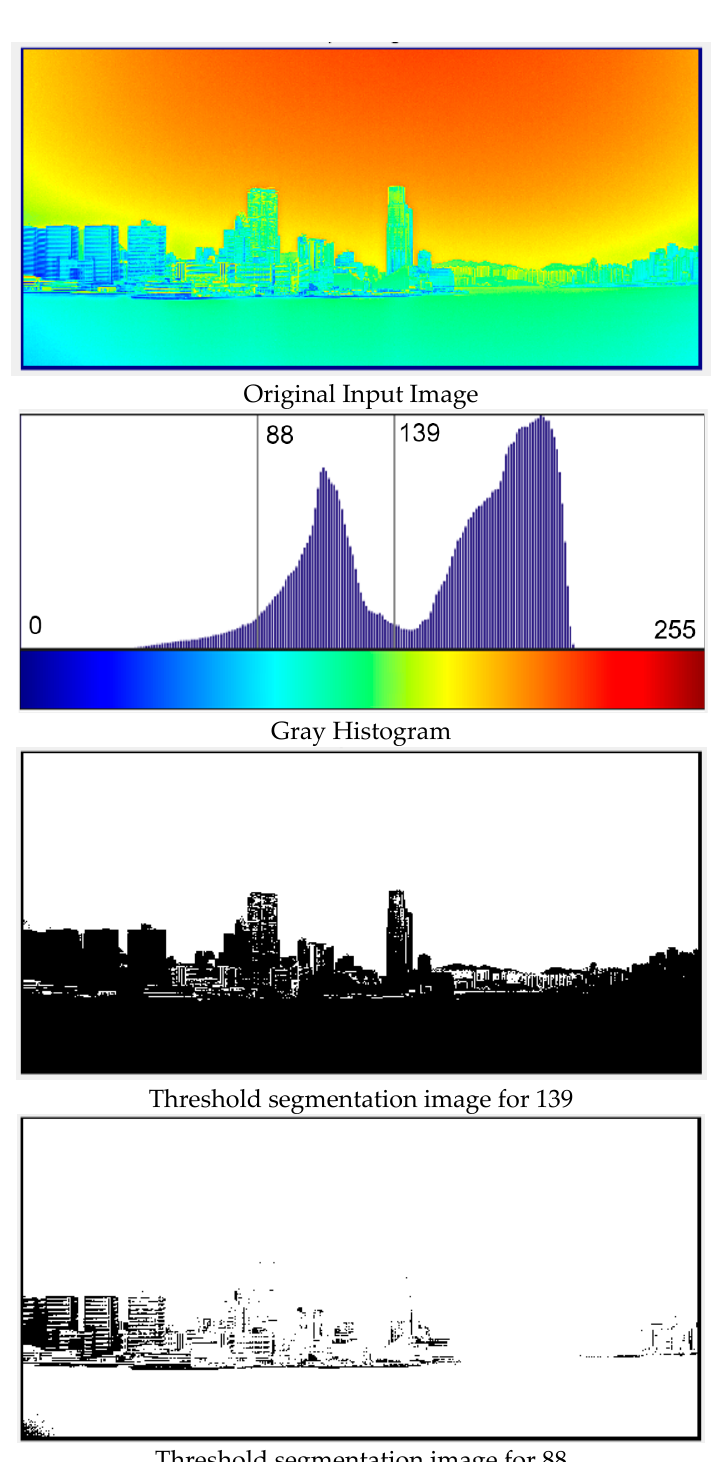
Figure 8. Threshold segmentation image after gray weighted average.